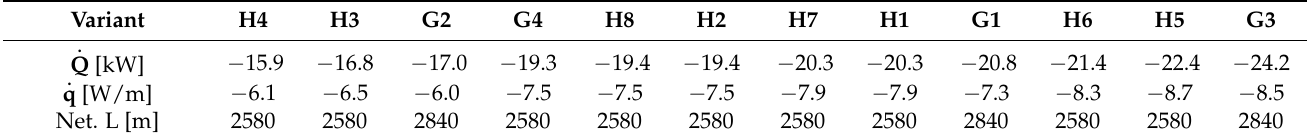
Table 10. Heat loss—Overview of the total distribution of heat loss . q , calculated according to network length L , for the different distribution variants simulated in loss this